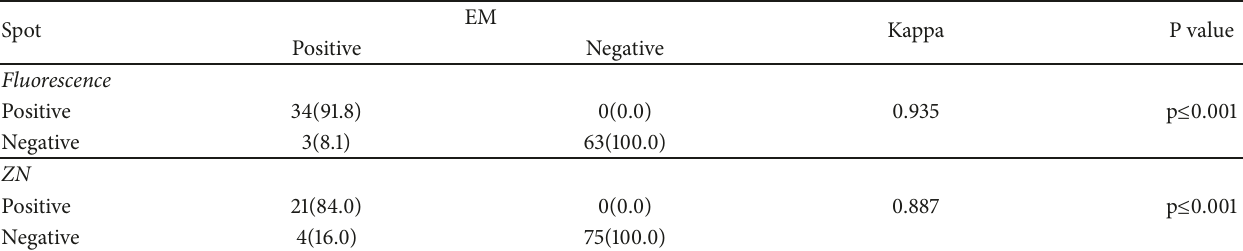
Table 5: Comparison of diagnostic yield of “spot” and “early morning” sputum